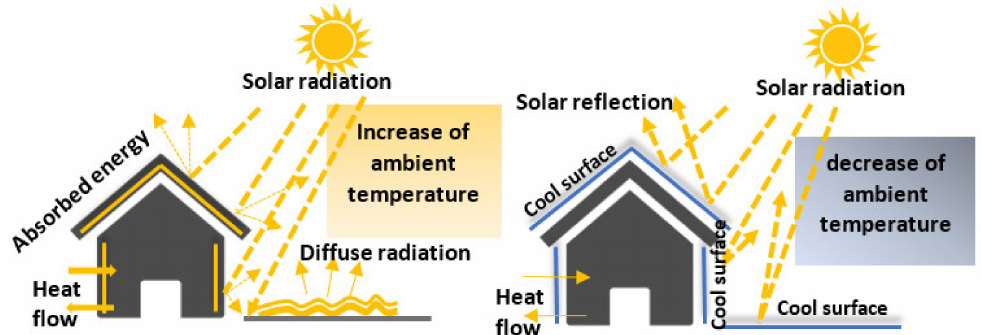
Figure 1. Schematic representation of the cool surface effect on a UHI through the ambient